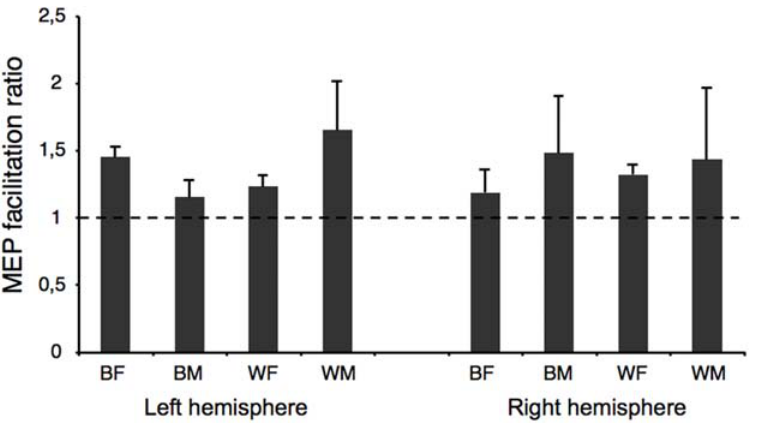
Figure 2. Facilitation ratios of all action conditions compared to baseline (mean and standard error). In all groups, passive observation of finger movements increases motor cortex excitability compared to baseline. BF: black female; BM: black male; WF: white female; WM: white male.